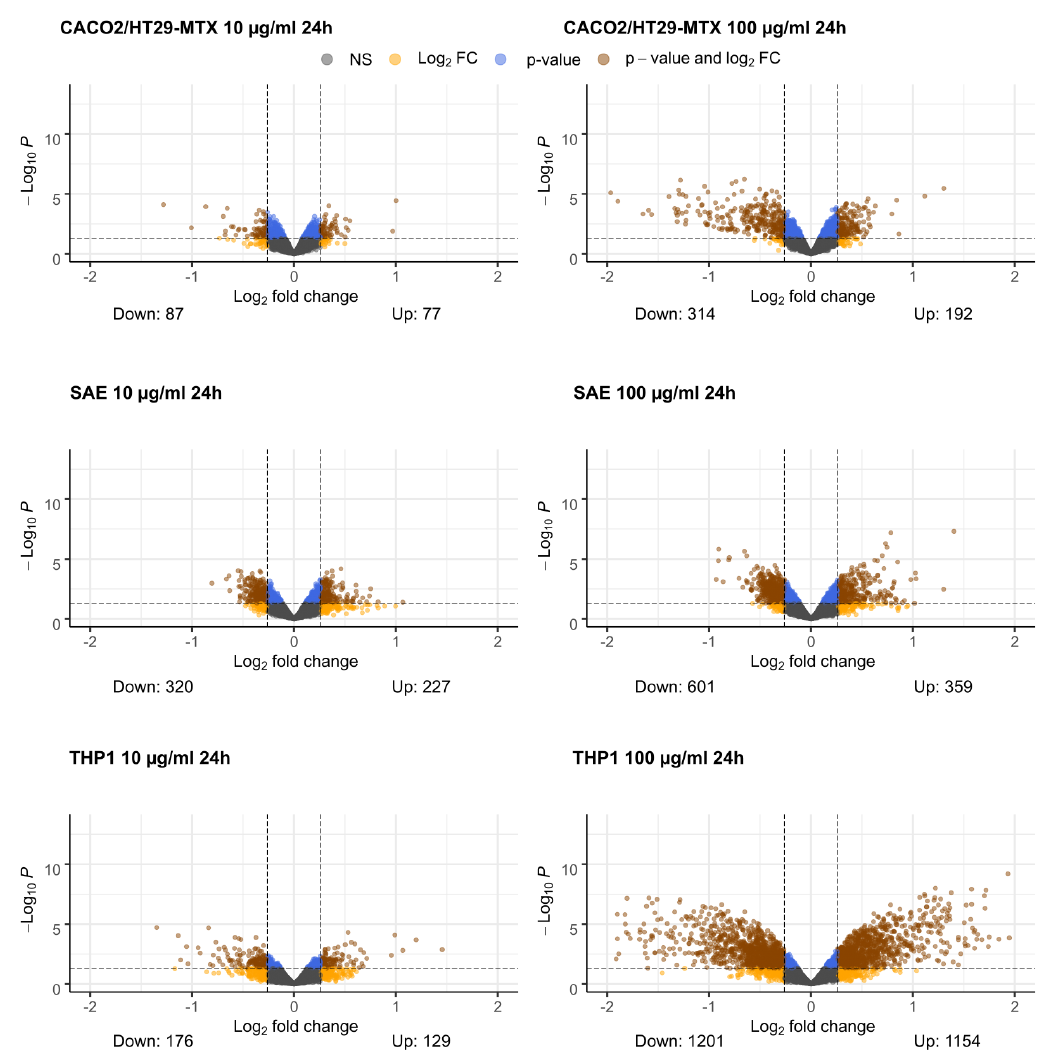
Figure 1. Gene expression volcano plots for different cellular models and TiO 2 -nanobelt concentrations. On the x-axis log 2 (fold change) is depicted whereas on the y-axis the -log 10 ( p -value) is depicted. The dotted lines represent cut-off values for significantly changed genes (log 2 fold change > 0.26 or < − 0.26, p -value < 0.05). A brown color depicts that a gene meets both cut-off criteria, a blue color relates to meeting only the p -value cut-off, an orange color relates to meeting only the log 2 fold change cut-off, and a gray color indicates that a gene does not meet any of the